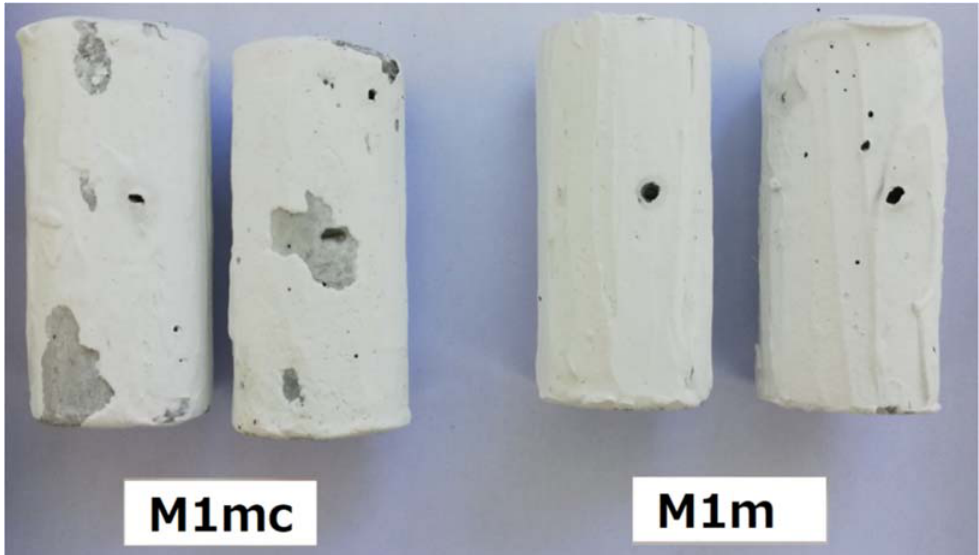
Figure 6. Coating performance (stability) of selected concrete samples under the influence (for 20 min) of high ‐ flow water velocities.